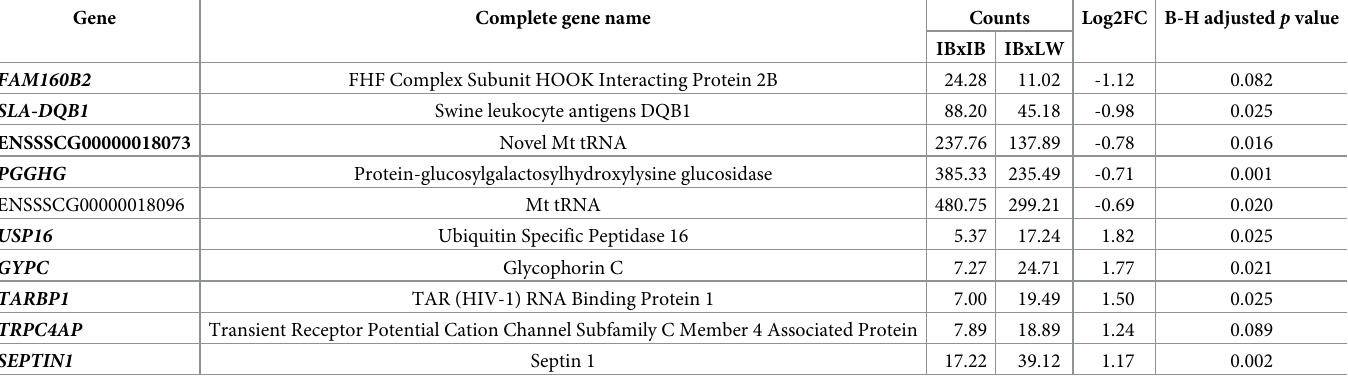
IBxIB = pure Iberian pigs; IBxLW: Iberian x Large White crossbreds; FC = fold change; B-H = Benjami Holchberg